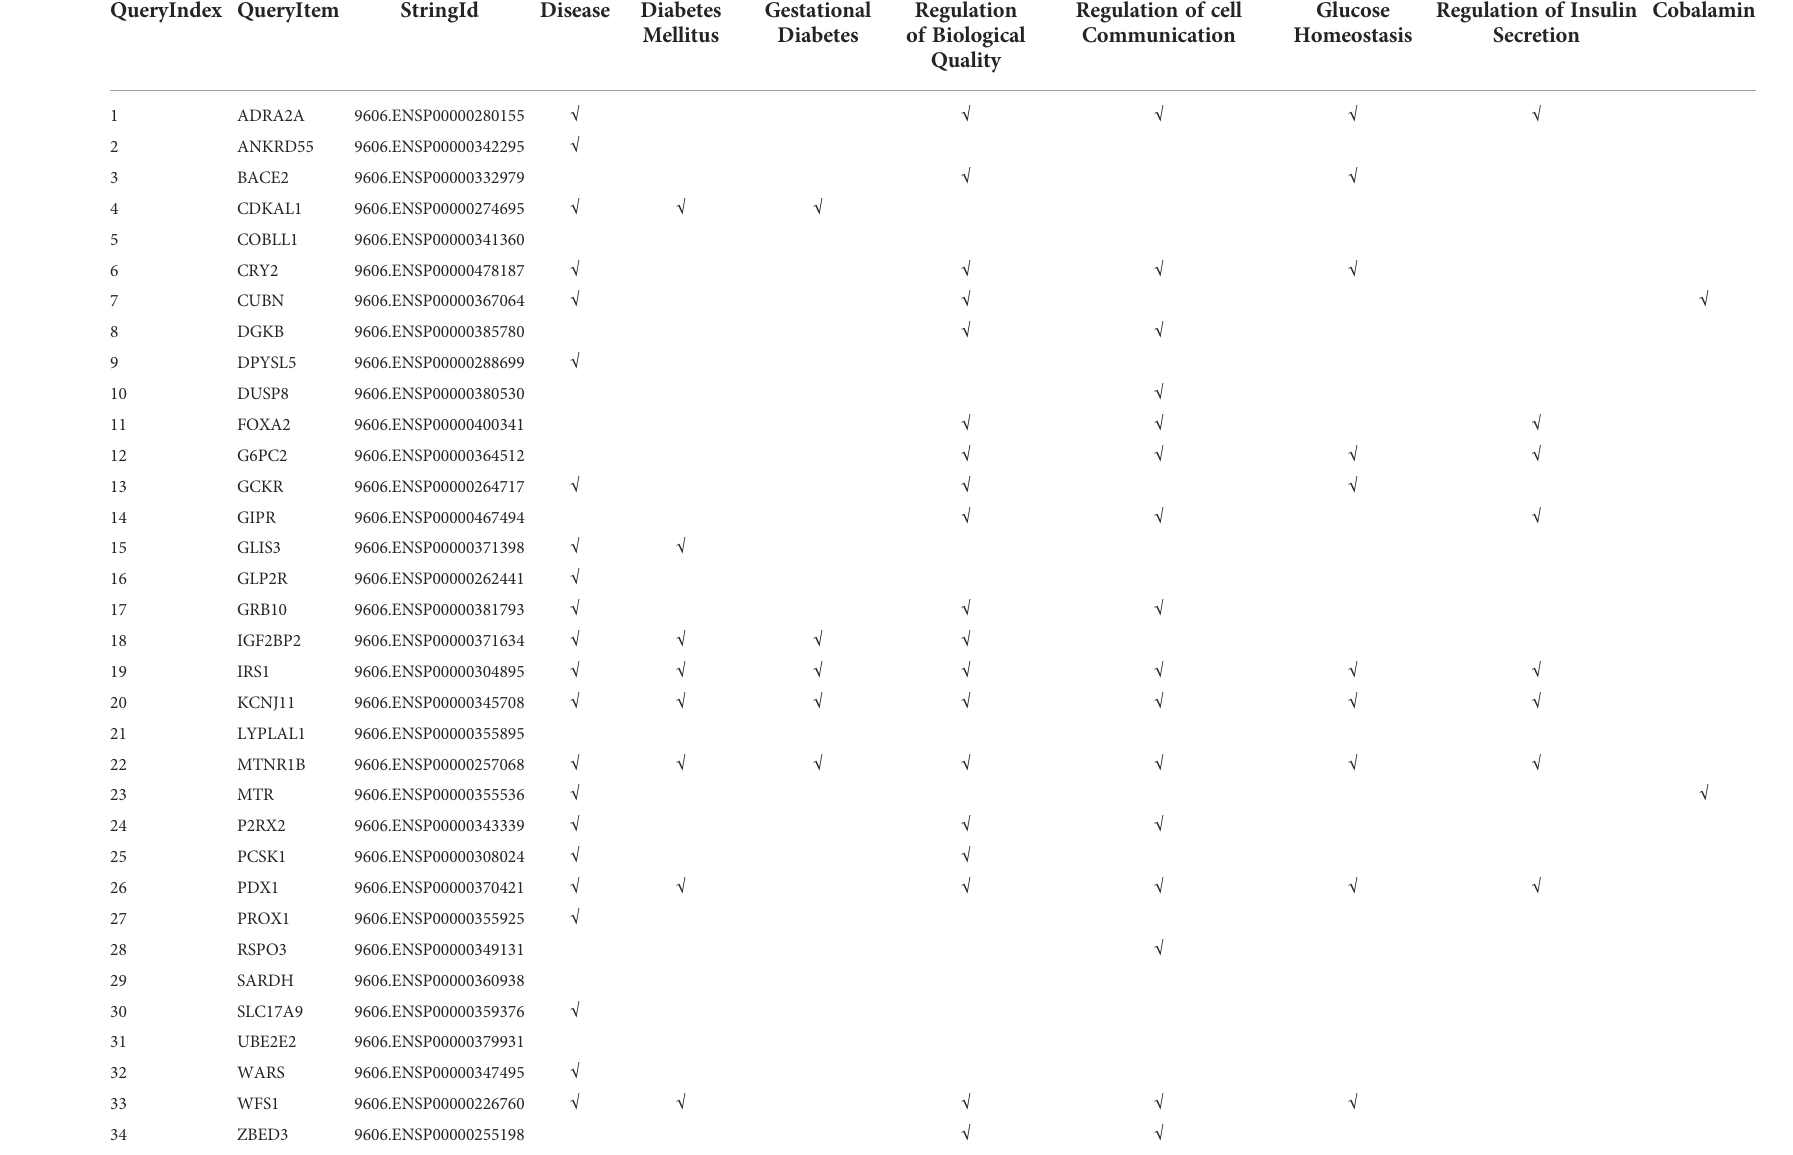
TABLE 4 Bioinformatic analysis relevant